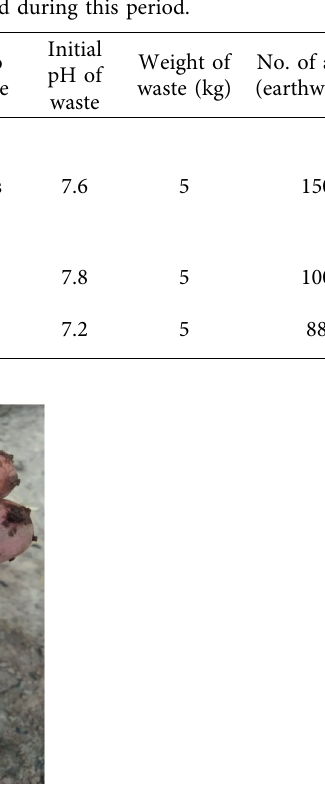
Table 1: Earthworm species consumed waste and the changes monitored during this period.